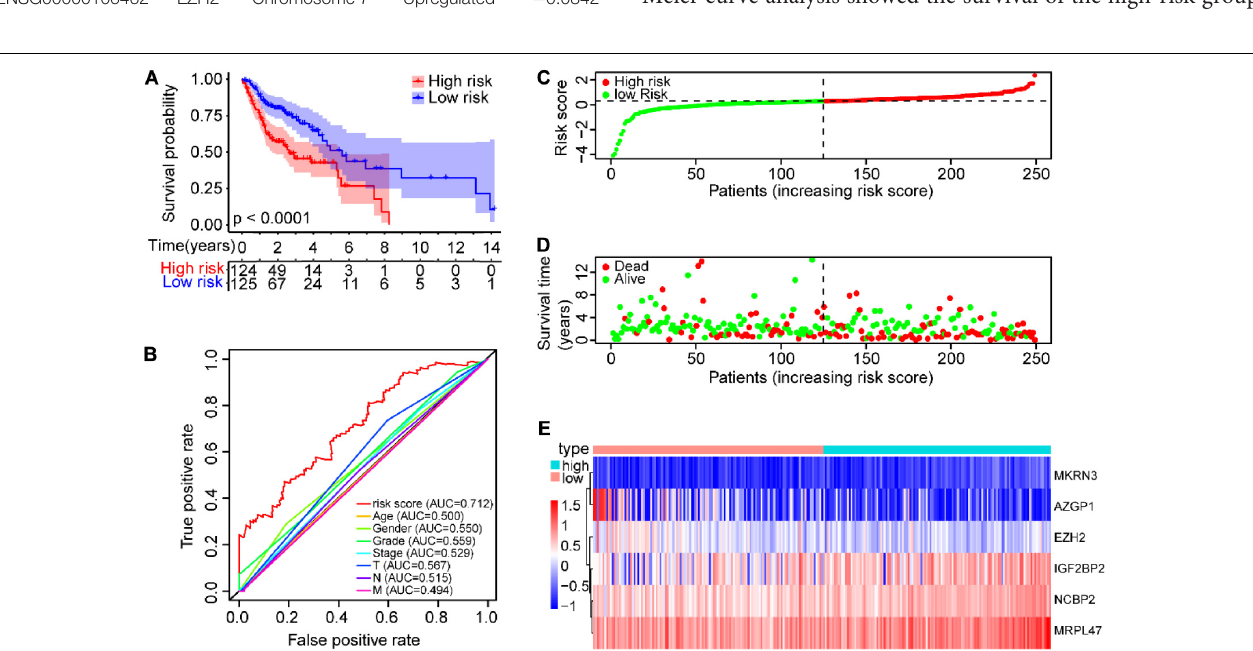
Frontiers in Genetics |